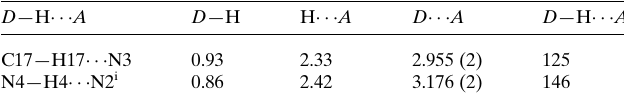
Table 1 Hydrogen-bond geometry (A˚ , (cid:2) ).